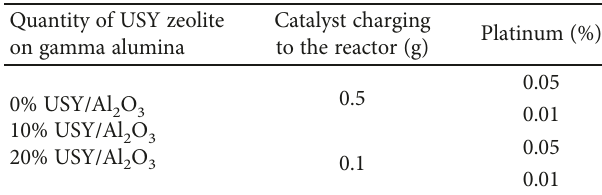
Table 1: Formulation of bifunctional catalyst for hydrotreatment of Jatropha curcas seed